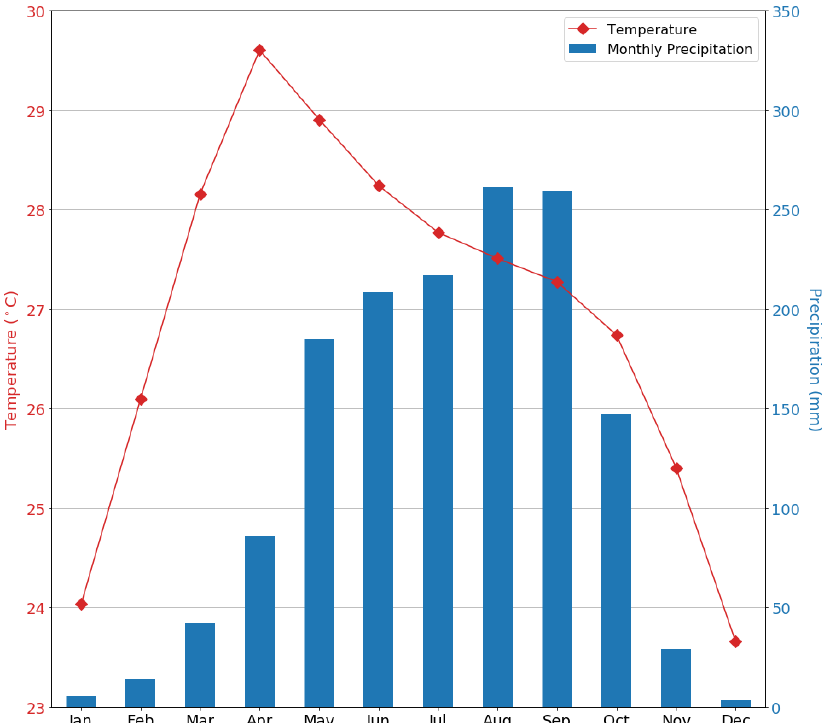
Figure 1. Average monthly precipitation and temperature for Thailand for 30 years from 1985 to 2014. Data sourced from the Climatic Research Unit (CRU) multivariate climate dataset